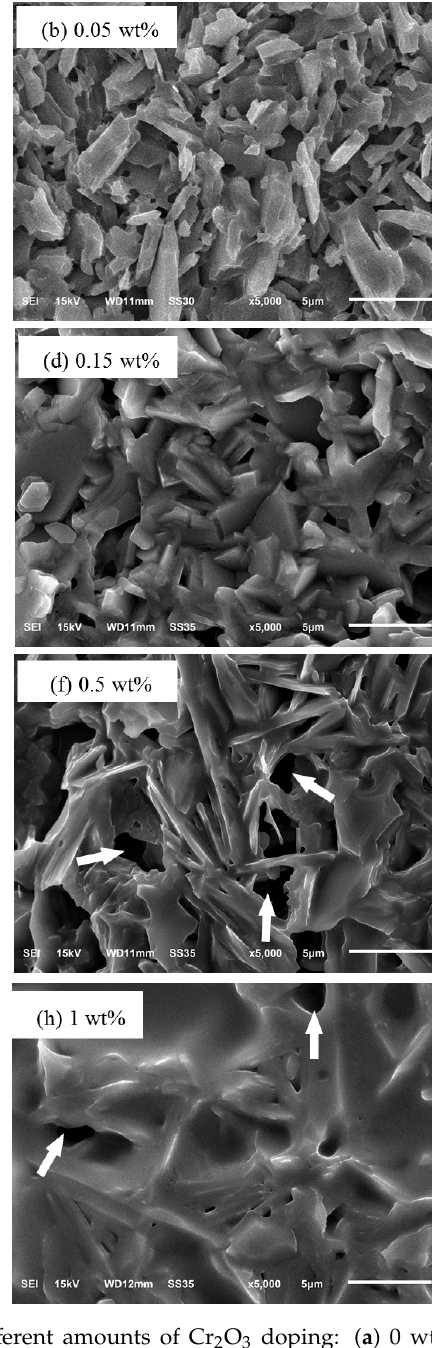
( b ) 0.05 wt%; ( c ) 0.1 wt%; ( d ) 0.15 wt%; ( e ) 0.25 wt%; ( f ) 0.5 wt%; ( g ) 0.75 wt%; ( h ) 1 Figure 5. The microstructures of the sinters for different amounts of Cr 2 O 3 doping: ( a ) 0 wt%; ( b ) 0.05